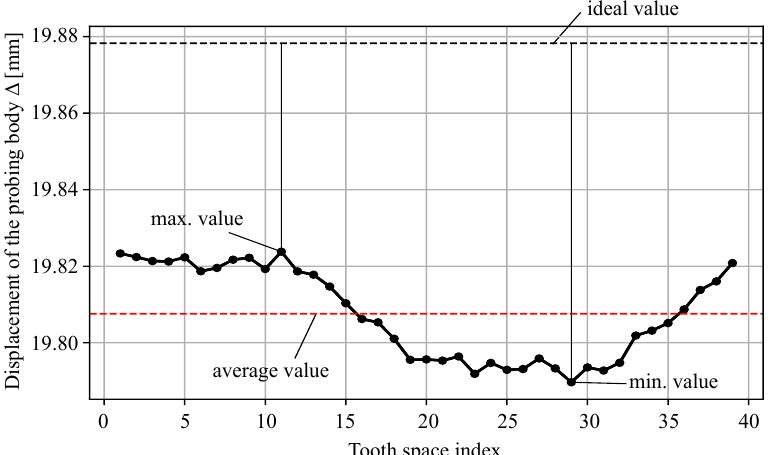
Figure 4. Parameter F mr determination procedure, using the maximum, minimum, and ideal values of the displacement of the probing